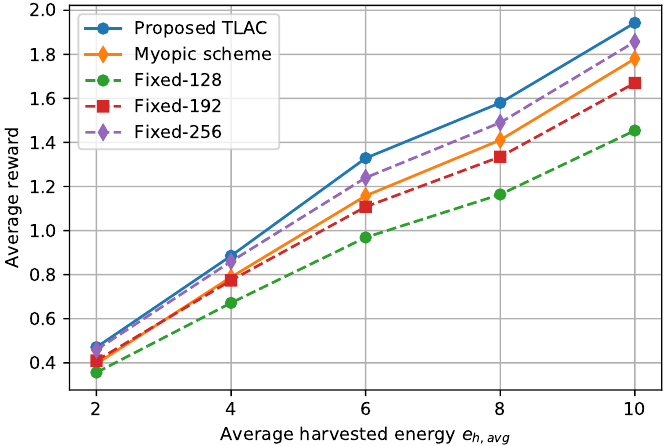
Figure 18. Reward comparison between the proposed TLAC and the fixed key-length schemes according to the harvested